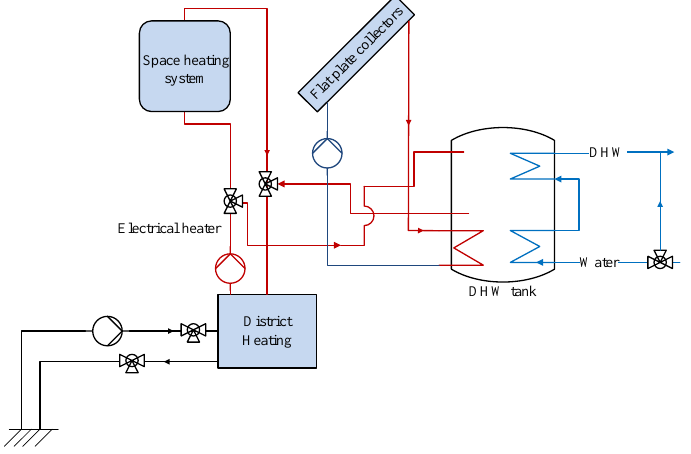
Figure 4. System schematics for the building with DH and solar thermal system.